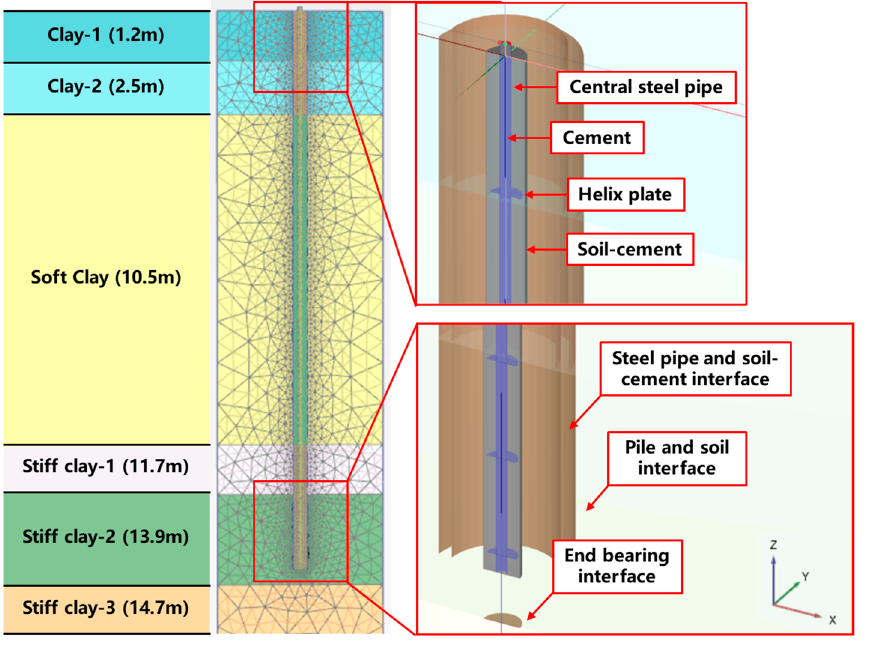
Figure 2. Diagram of the FEM.